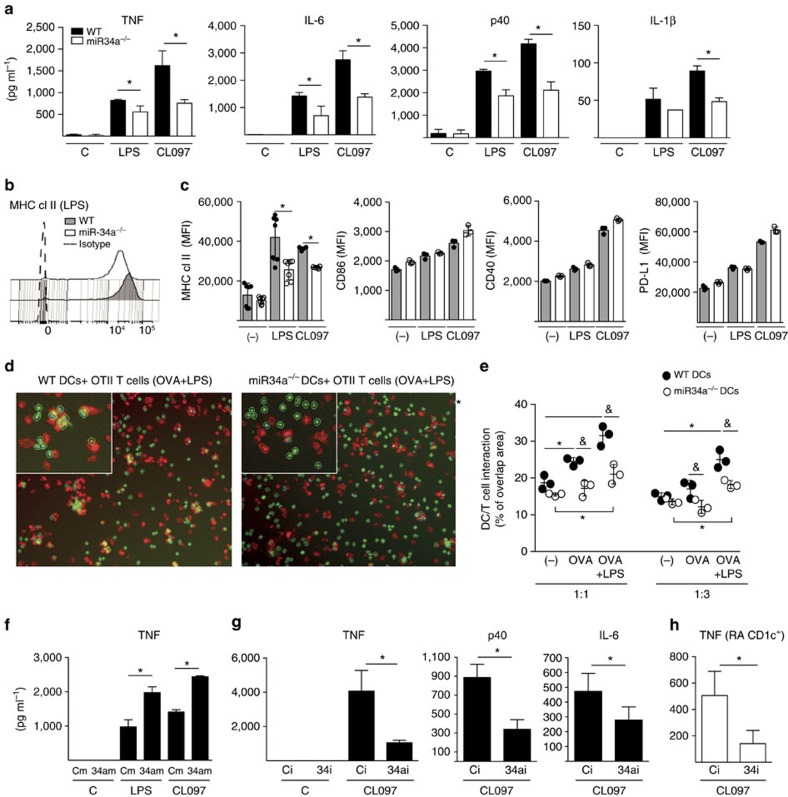
MiR-34a drives DC activation.(a) miR-34a−/− DCs show reduced production of pro-inflammatory cytokines. Bone marrow DCs from WT and miR-34a−/− mice (n=6 pooled) were stimulated with LPS or CL097 for 24 h. (b,c) miR-34a−/− DCs show reduced expression of MHC class II. WT and miR-34a−/− DCs were stimulated as in a for 24 h and the expression of co-stimulatory molecules was evaluated as median fluorescent index (MFI) by flow cytometry. Representative MFI expression of MHC class II (b), and quantitative expression of MHC class II, co-stimulatory (CD40 and CD86), and inhibitory (PD-L1) molecules is shown (c). *P<0.05 Mann–Whitney u-test between genotypes. Data are presented as mean±s.e.m. of 4–6 replicates from two independent experiments. (d,e) miR-34a−/− DCs show a reduced interaction with antigen-specific T cells. CMTPX-labelled WT and miR-34a−/− DCs were co-cultured with CFSE-labelled OT-II CD4+ T cells at 1:1 or 1:3 ratios in the presence of OVA peptide or OVA plus LPS for 24. The contact area was analysed with In Cell Analyzer 2000. Representative pictures of 1:1 cultures (d) and quantitative evaluation (e) presented as mean±s.e.m. of % of overlapping areas between DC and T cells compared to the total cell surface area (six technical replicates in total) are shown. *P<0.05 between conditions, &P<0.05 between genotypes, two-way ANOVA followed by Tukey’s multiple comparison test or unpaired t-test. (f,g) miR-34a regulates pro-inflammatory cytokine production by human DCs. (f–h) Healthy donor monocyte-derived inflammatory DCs (n=4–5) were transfected with miR-34a mimic (34am) or miR-34a inhibitor (34i) or appropriate controls (Cm=mimic or Ci=inhibitor); and (g) DCs (conventional CD1c+ DCs; n=7) were sorted from RA patients’ blood and transfected with miR-34a inhibitor (34i) or control inhibitor (Ci). The DCs were then stimulated with LPS or CL097 for 24 h. (f) Enforced expression of miR-34a increased TNF production; *P<0.05, Kruskal–Wallis followed with Dunn’s multiple comparison tests or paired t-test. (g,h) miR-34a inhibitor reduced the production of cytokines by healthy donor monocyte-derived DCs (g) and sorted PB RA CD1c+ DCs (h). *P<0.05 paired t-test. (f,g) Data are presented as mean±s.e.m of 4–7 biological replicates obtained in separate experiments. ANOVA, analysis of variance.